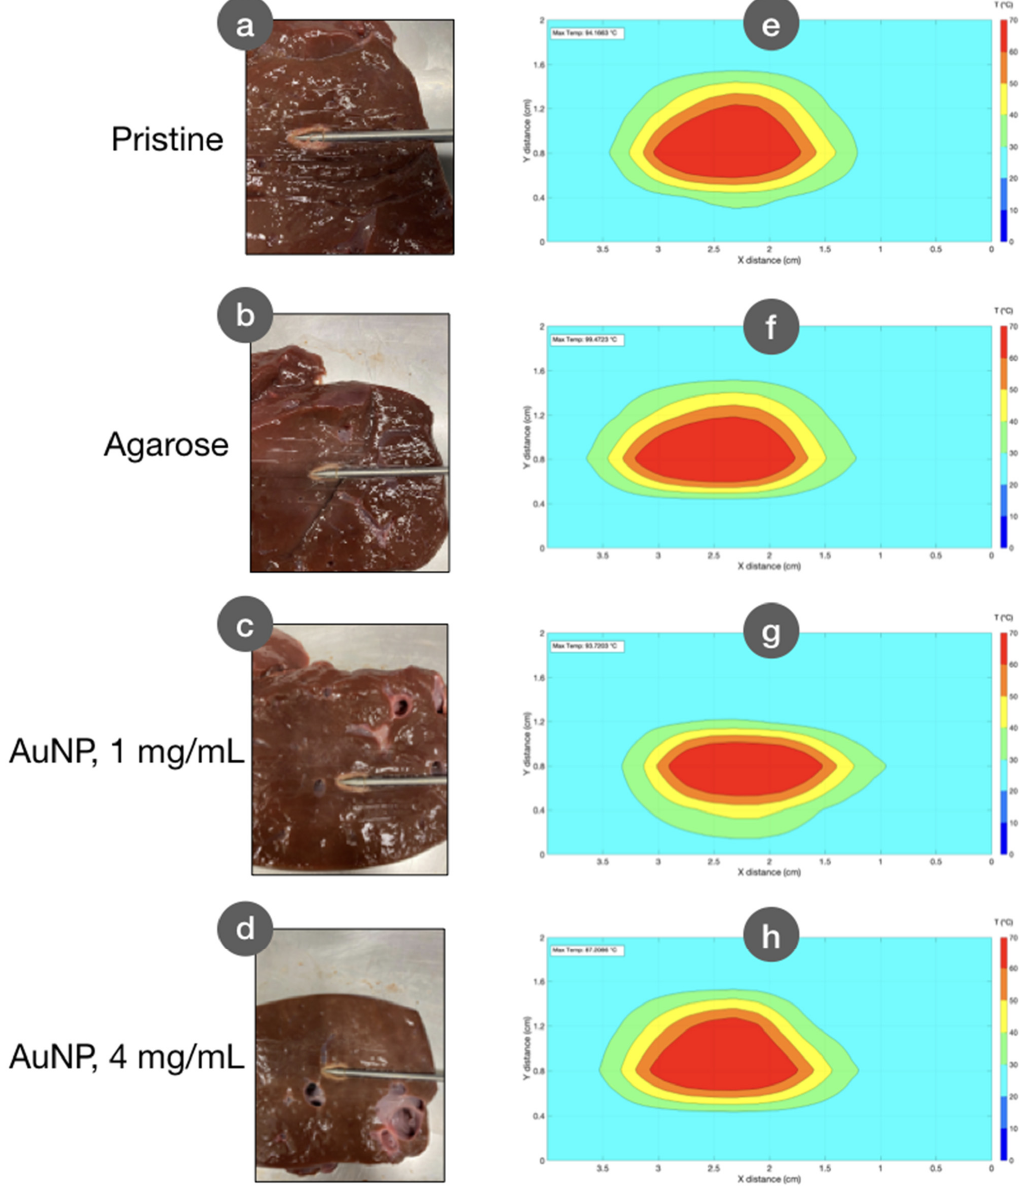
Figure 9. Thermal maps observed for different conditions, compared to the photograph of the ablated tissue. ( a – d ) Photographs of the tissue after RFA procedure; ( e – h ) thermal maps observed at the peak temperature condition. Experiments have been performed in pristine condition ( a , e ), with agarose gel inserted in the tissue ( b , f ), and with AuNP with densities of 1 mg/mL ( c , g ) and 4 mg/mL ( d , h ).